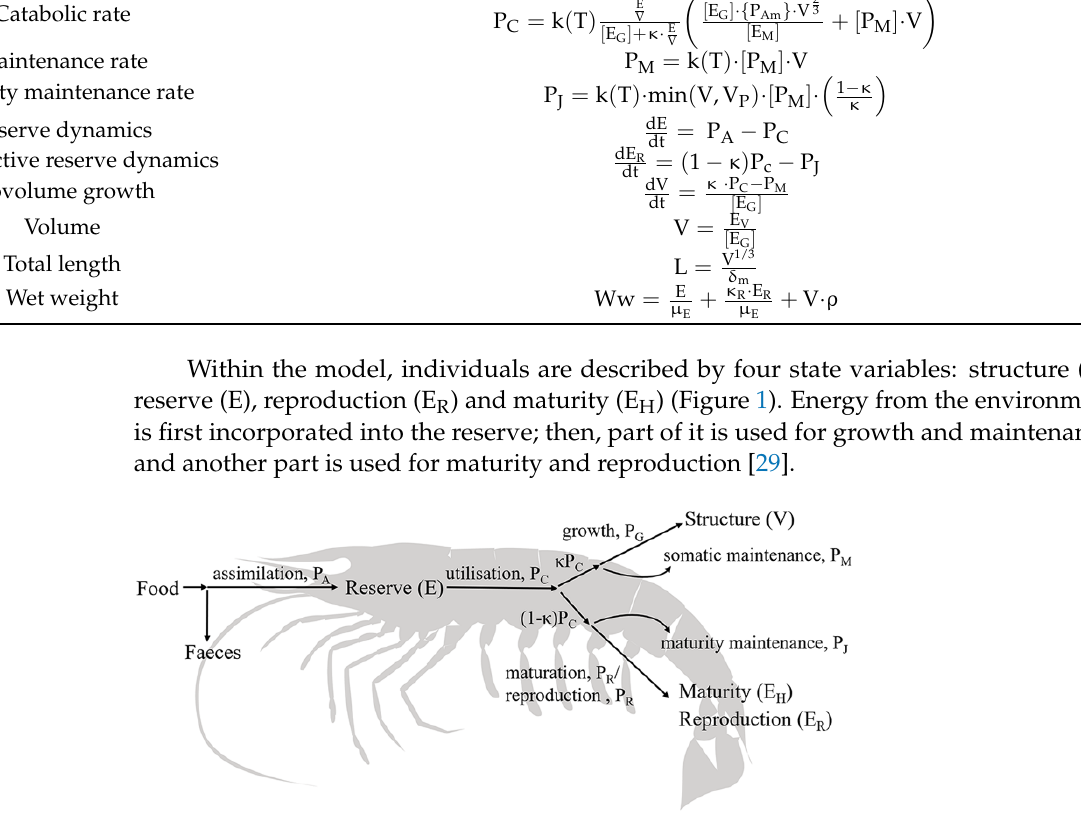
Figure 1. Schematic representation of the parameters used to describe kuruma shrimp in a standard DEB model.